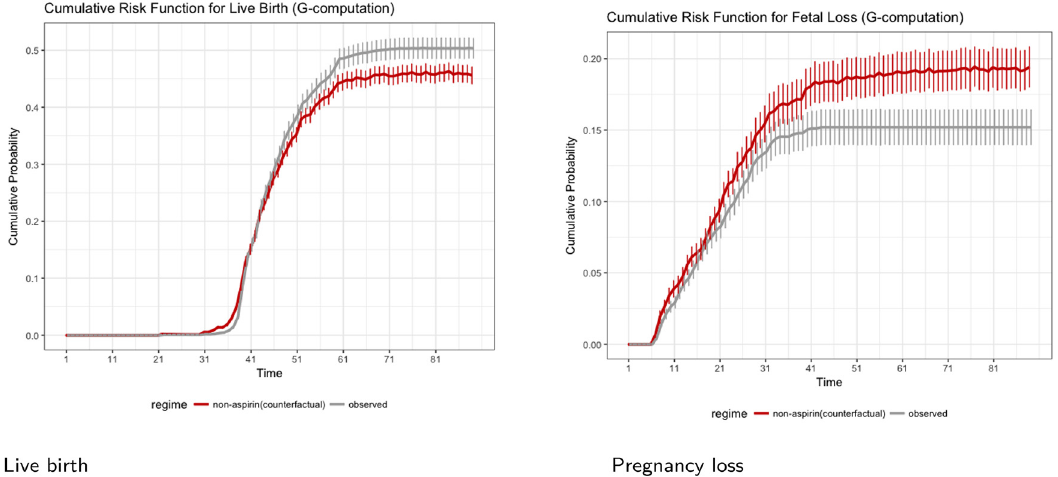
Figure A5: Cumulative risk curve for live birth and pregnancy loss via the regression based g - computation estimator. Pointwise 95% con fi dence interval is estimated by bootstrapping with 1,000 resampling.